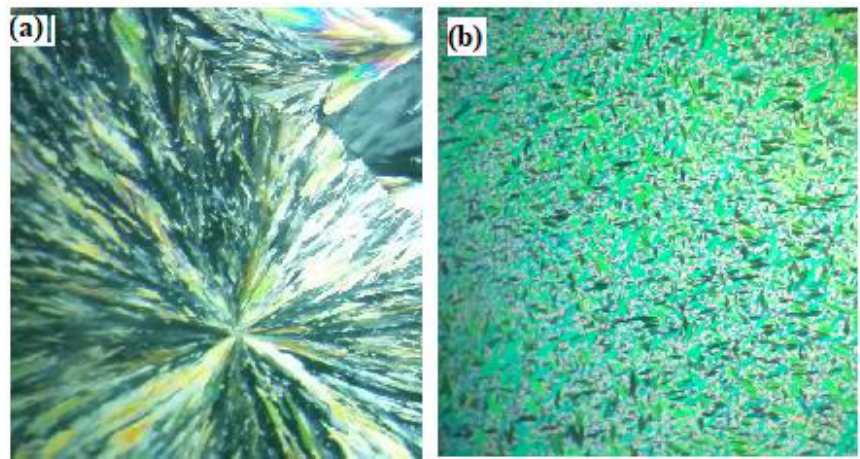
Figure 2. Differential scanning calorimetry (DSC) thermograms upon heating/cooling cycles of compound I with heating rate 10 °C/min.